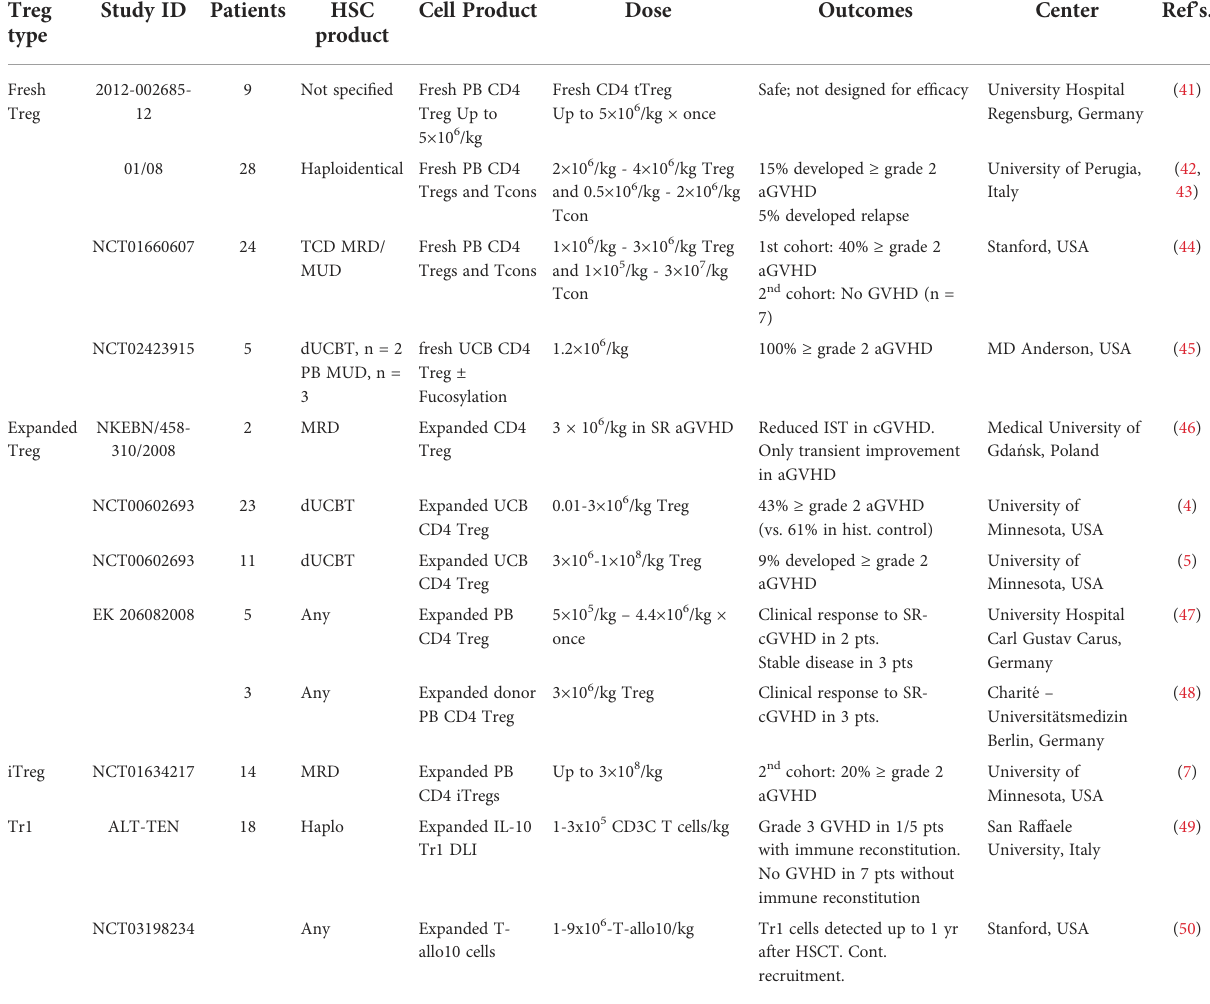
TABLE 1 Completed clinical trials with results involving adoptive Treg therapy in GVHD (search date March 30, 2022). Treg